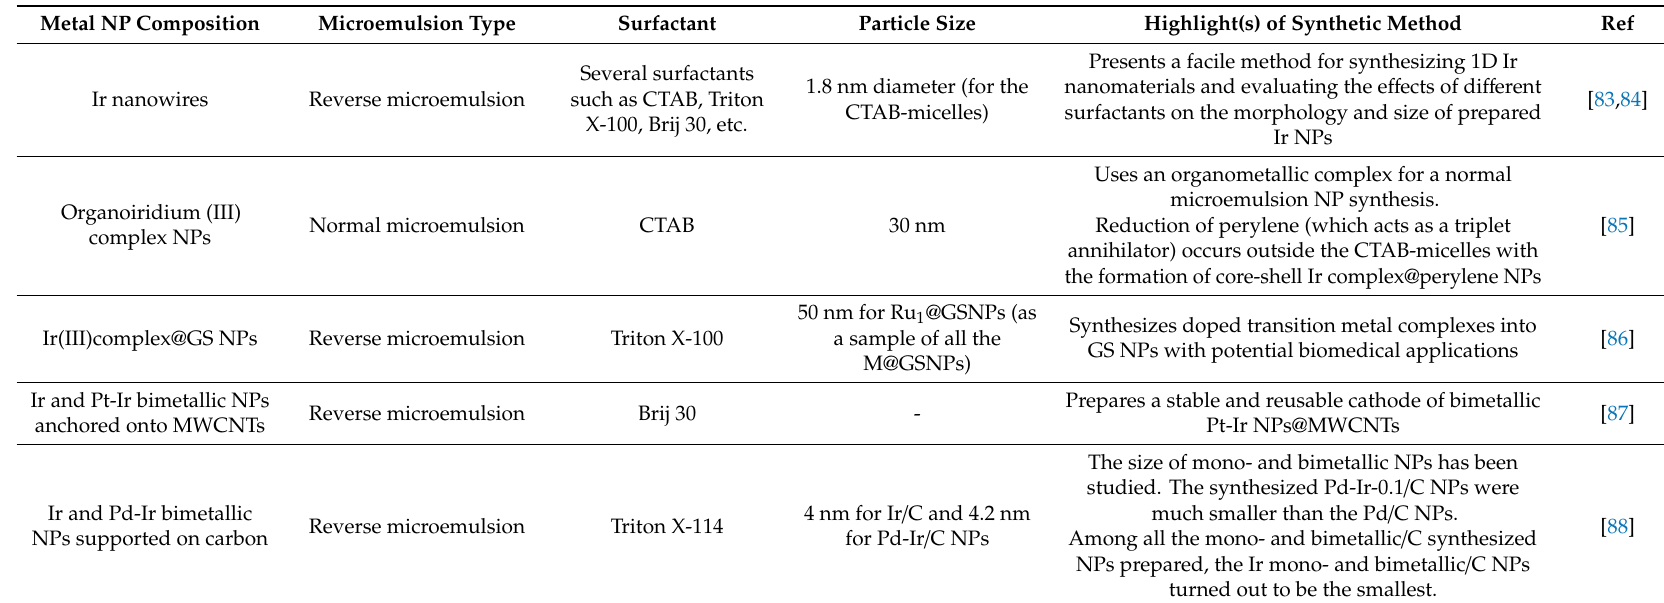
Table 2. Recent development in microemulsion-based synthesis of Ir NPs. CTAB—cetyl trimethyl ammonium